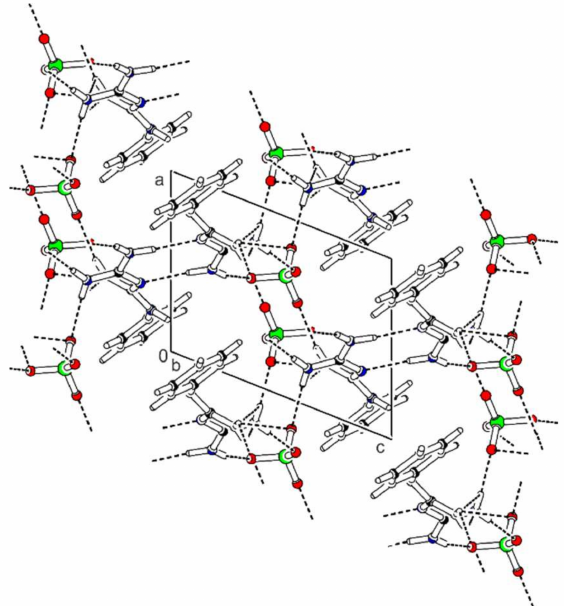
Figure 2. Packing scheme of phbiguaClO 4 (view along the b axis direction); dashed lines indicate hydrogen bonds, solid lines indicate unit